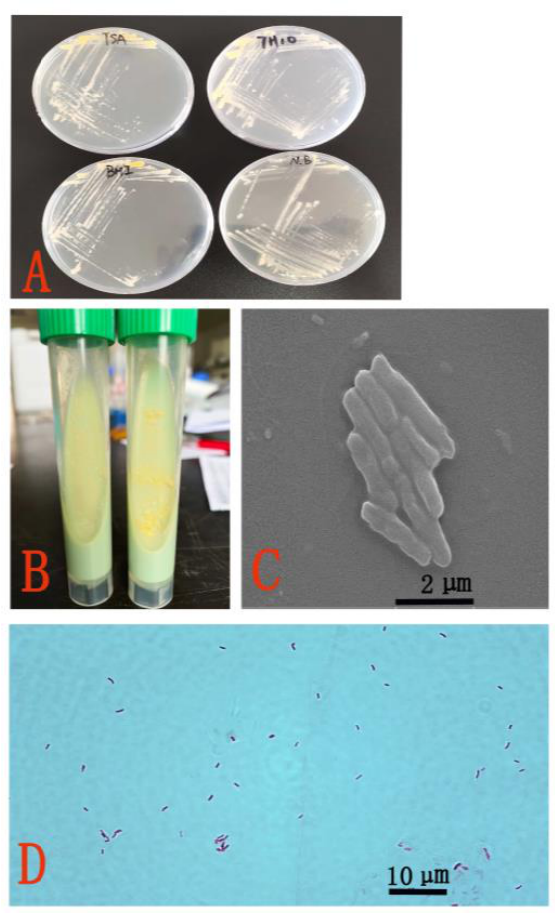
Figure 2. Morphological characteristics of colonies and strain ZHLJ2019. ( A ) Strain ZHLJ2019 grown on TSA, BHIA, NA, and Middlebrook 7H10 agar. ( B ) Strain ZHLJ2019 grown on LJM. ( C ) Scanning electron micrograph of the strain ZHLJ2019 (scale bar = 2 μ m) ( D ). Morphological characteristics of the strain ZHLJ2019 were obtained using Ziehl – Neelsen staining (scale bar = 10 μ m). Table 2. Comparison of phenotype characteristics of the strain ZHLJ2019 and M. marinum ATCC nitrite, urease, aromatic sulfatase, nicotinic acid, pyrazinamidase, Tween-80 hydrolysis, 927. thiophene-2-carboxylic acid, glucose agar, and growth at 25 ◦ C and 37 ◦ C and